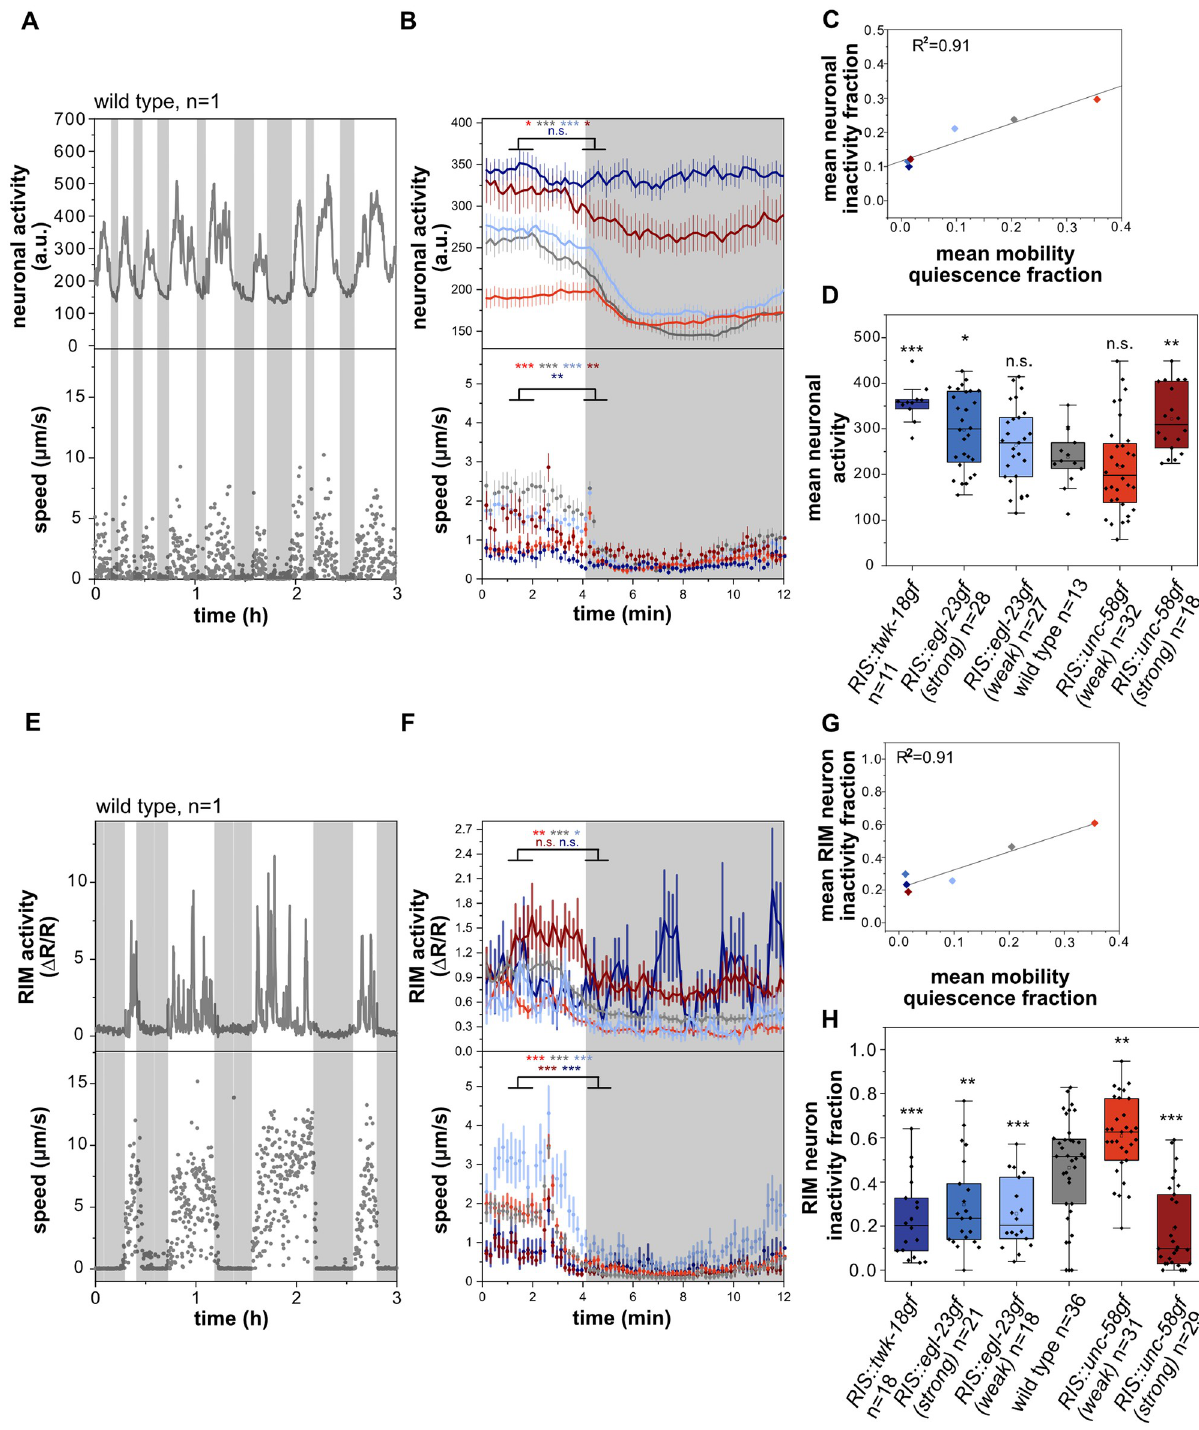
Fig 6. RIS :: unc-58gf(strong) fails to inhibit wake-active circuits. A-B) Reduced global neuronal activity (grey shading) correlates with motion quiescence (S1–S6 Movies). Head speed was measured. A) sample trace, B) alignment of overall neuronal activity to mobility quiescence bout onset. ��� p < 0.001, Wilcoxon signed rank test. C) The mean neuronal inactivity fraction correlates with the mean mobility quiescence fraction (linear fit) for all strains. D) Strong RIS inactivation as well as RIS :: unc-58gf(strong) caused an overall increase of neuronal activity. n.s. p > 0.05, � p < 0.05, �� p < 0.01, ��� p < 0.001, Welch test with FDR correction for multiple testing. E-F) RIM does not activate during mobility quiescence bouts. RIM speed was measured F) Sample trace (grey shade is RIM inactivity bout). Alignment of RIM activity and speed to mobility quiescence bout onset. � p < 0.05,